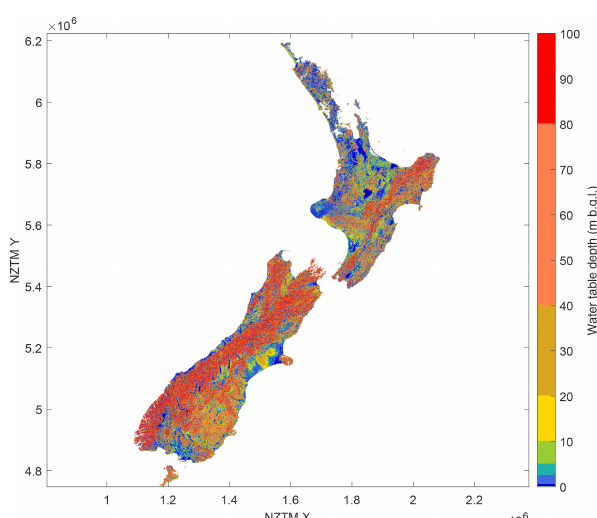
Figure 3. Hydraulic conductivity estimates for near-surface geol- ogy across New Zealand.